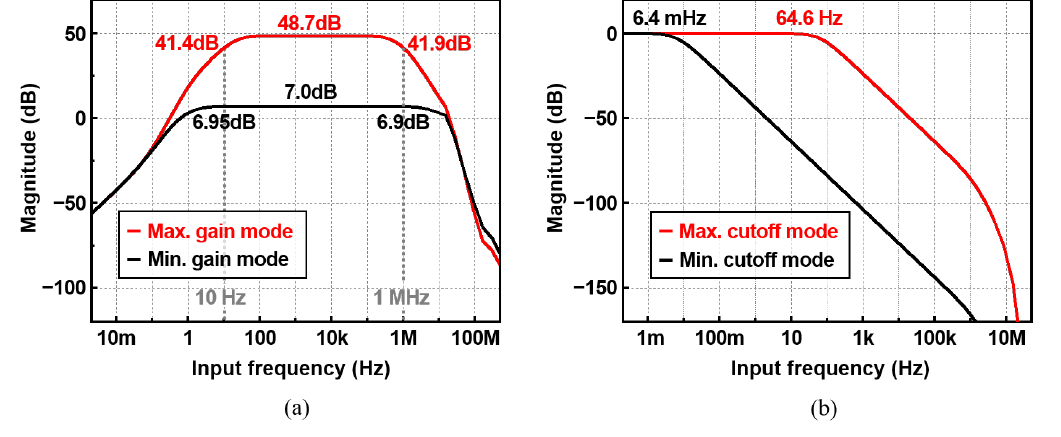
Figure 11. Frequency response of ( a ) the IA and ( b ) the